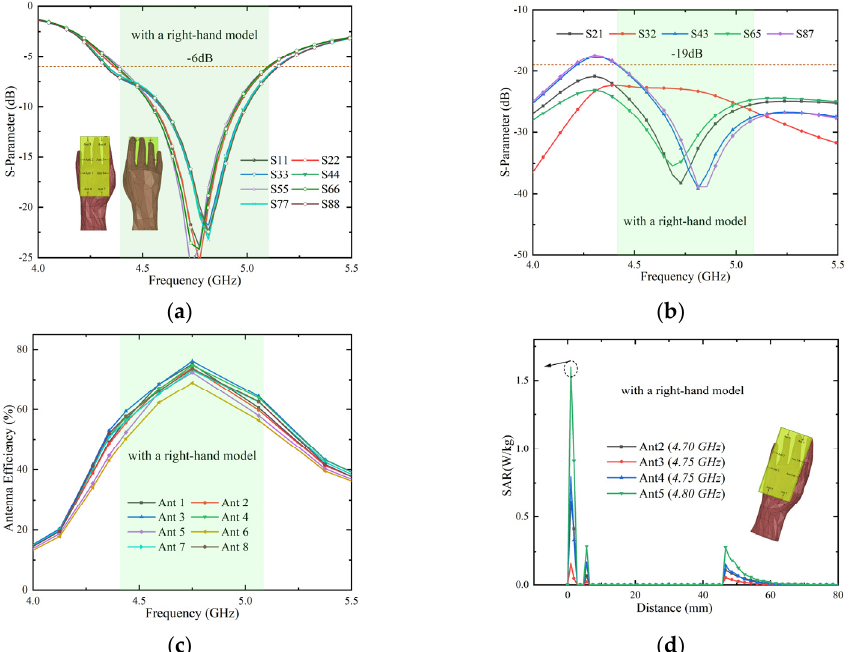
Figure 19. Simulation results of the proposed MIMO antenna with a right-hand model. ( a ): Reflection coefficients with a right-hand model, ( b ): transmission coefficients with a right-hand model, ( c ): total efficiency with a hand model, and ( d ): SAR with a right-hand model.